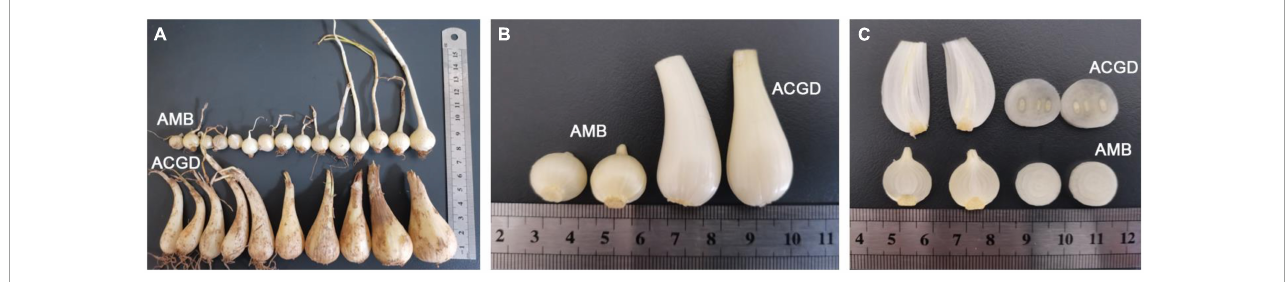
FIGURE1 The overall morphology (A) , locally enlarged phenotype (B) , and cross section and longitudinal section (C) of fresh bulbs of Allium macrostemon Bge. (AMB) and Allium chinense G. Don (ACGD).